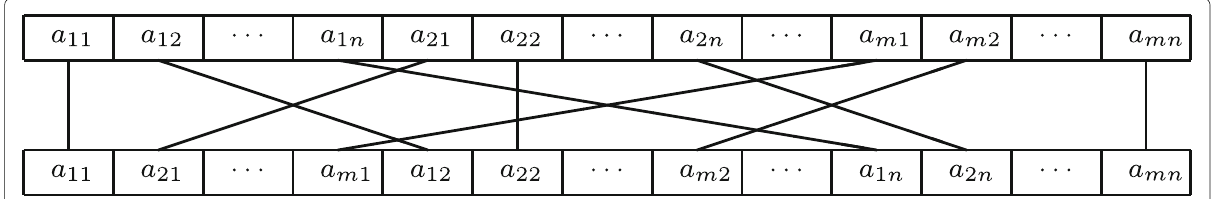
Fig. 1 The wire link permutation W applied in the proposed concatenated schemes ( i ) ( a ( i ) , a , ··· , a 11 12